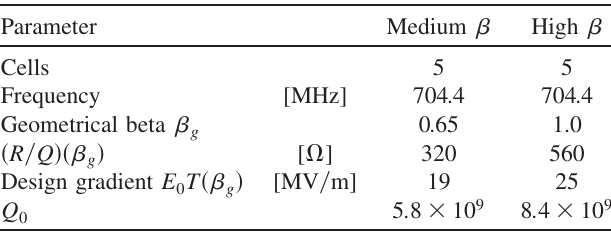
TABLE II. Cavity design parameters.